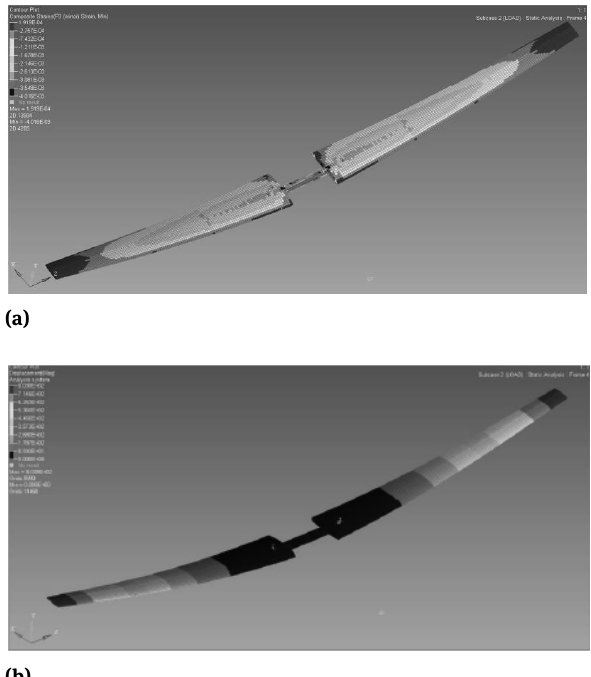
Figure 7: The result of finite element (FE) analysis, (a) is the strain distribution nephogram, (b) is the deformation distribution nephogram